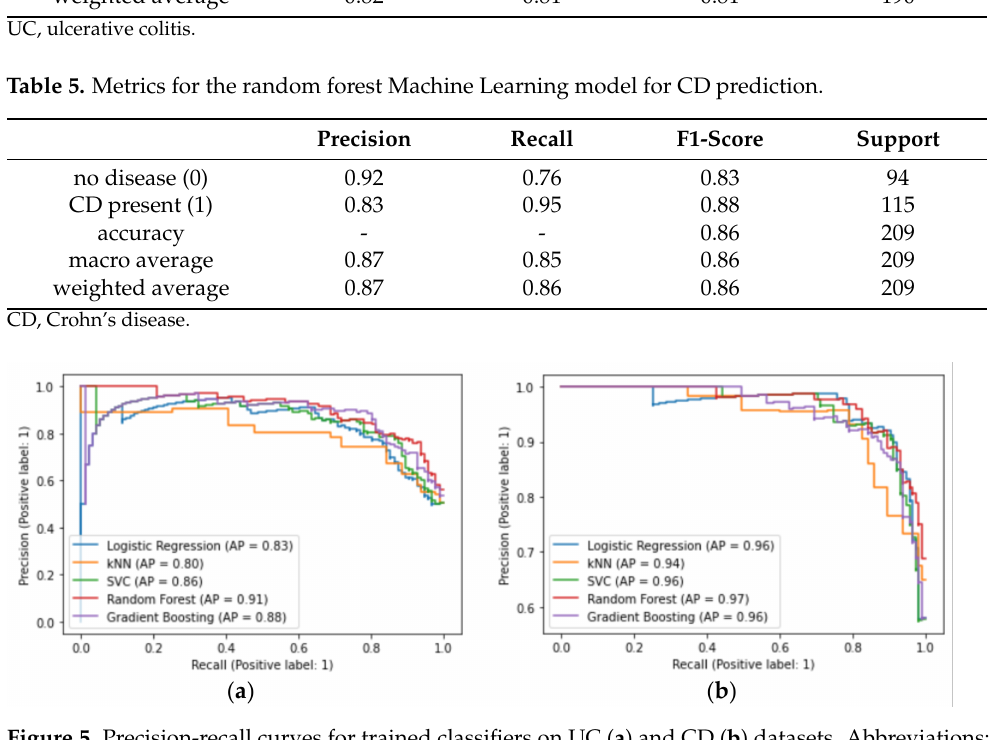
Figure 5. Precision-recall curves for trained classifiers on UC ( a ) and CD ( b ) datasets. Abbreviations: kNN, k-nearest neighbor; SVC, support vector classifiers; AP, average